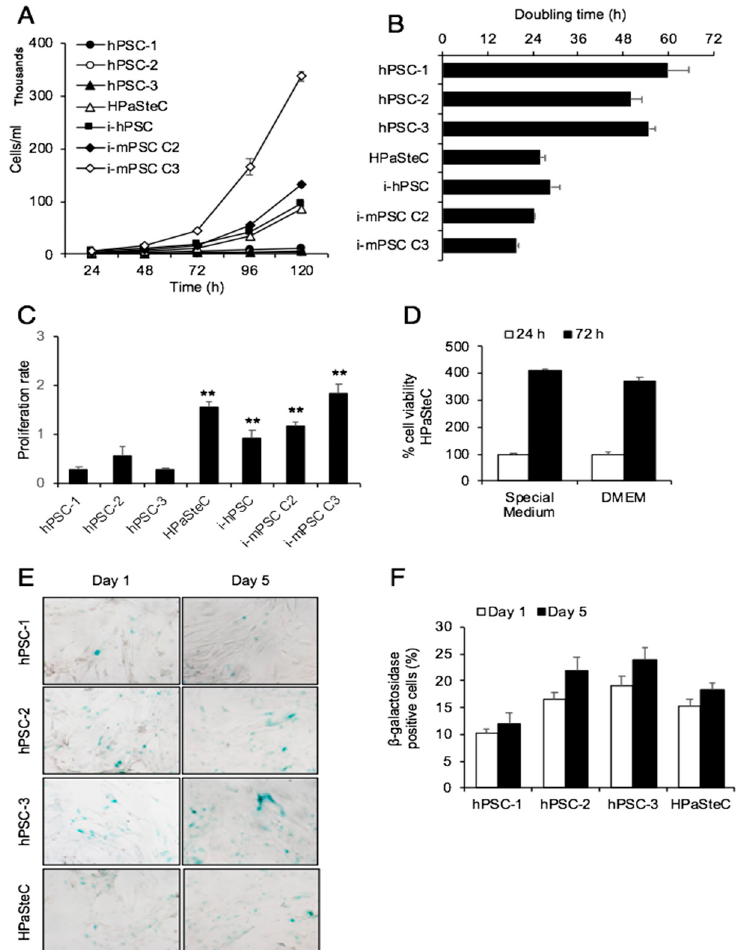
Figure 2. Growth curves and doubling time. Growth curves ( A ) and doubling time ( B ) were determined by counting cell numbers every 24 h for 5 days. ( C ) Cell proliferation rate was obtained by measuring the percentage of cell viability by the MTT assay at 24 and 72 h after cell seeding. ( D ) Percentage of cell viability of HPaSteC cells measured by the MTT assay at 24 and 72 h after cell seeding in special or DMEM medium. ( E , F ) β -galactosidase staining of primary cultures, including hPSCs and HPaSteC, performed at 24 h (day 1) and 120 h (day 5) after cell seeding ( E ) and percentage positive cells, using ImageJ software for cell counting ( F ). Data are mean ± SEM of triplicate determinations. ** p < 0.01 comparing average of hPSCs with HPaSteC, i-hPSC, and i-mPSCs for ( C ). PSC, pancreatic stellate cell; hPSC, human primary PDAC-derived PSC culture; HPaSteC, PSCs from normal human pancreas; i-hPSC, immortalized human PSCs; i-mPSC C2 and C3, immortalized mouse PSCs clone 2 and 3.